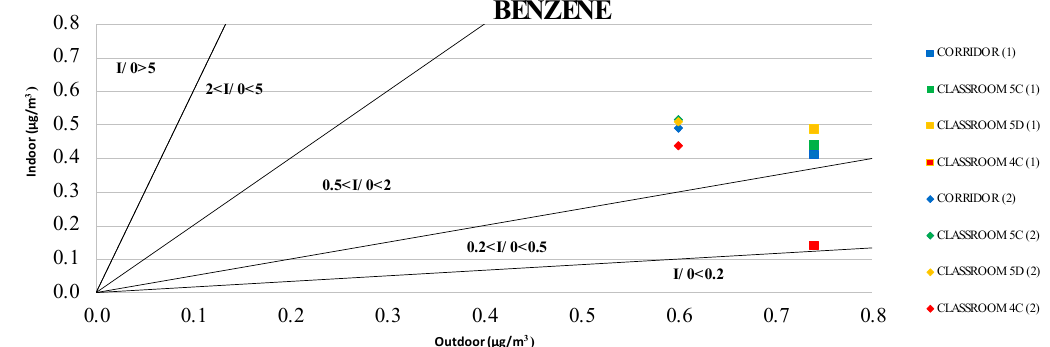
Figure 1. Benzene indoor concentrations against outdoor concentrations in all monitored sites during the first (1) and the second (2) monitoring periods.